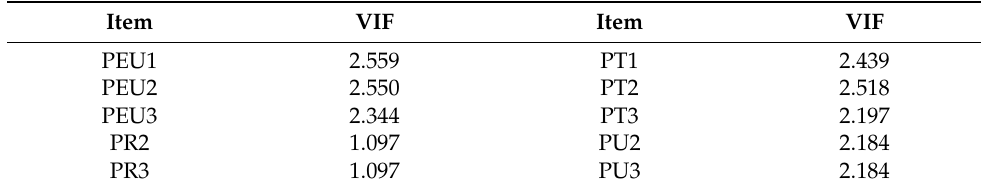
Table 6. VIF values for the formative